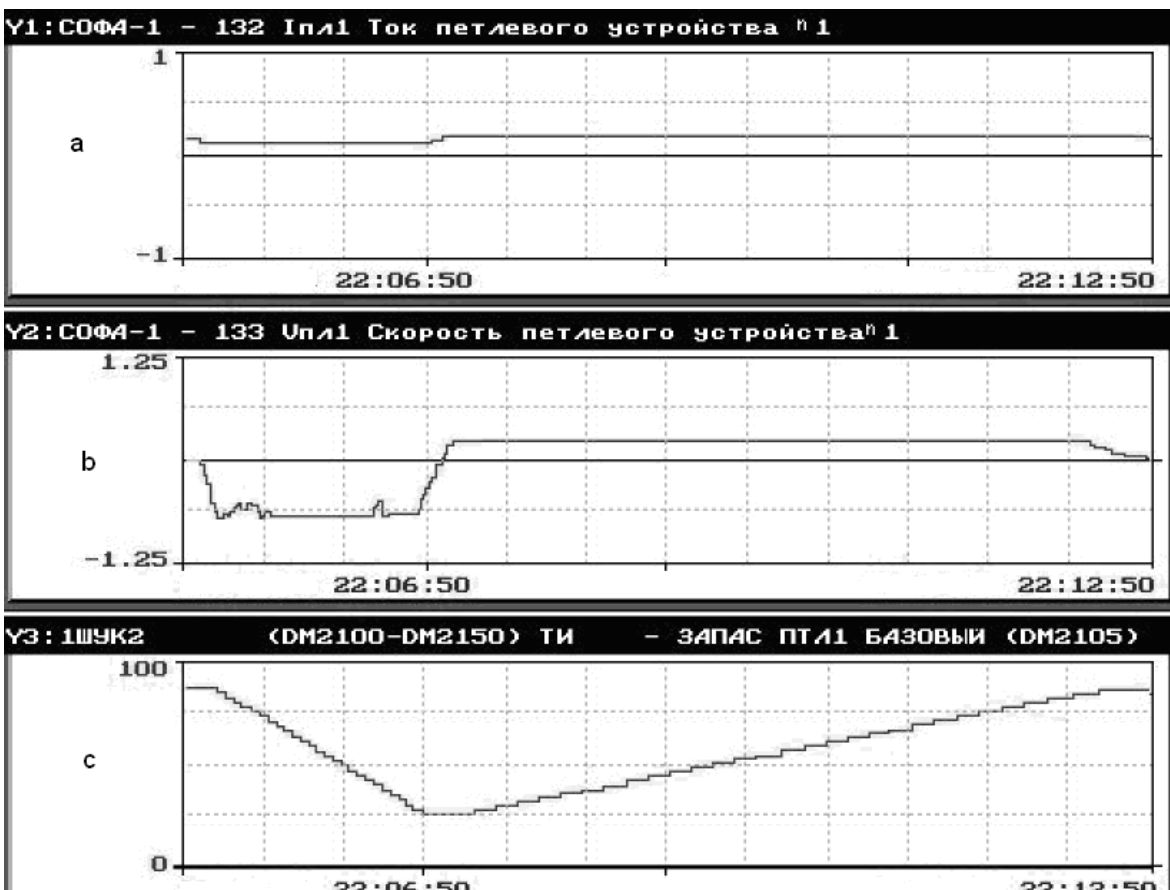
Figure 2. Changing the parameters of the horizontal